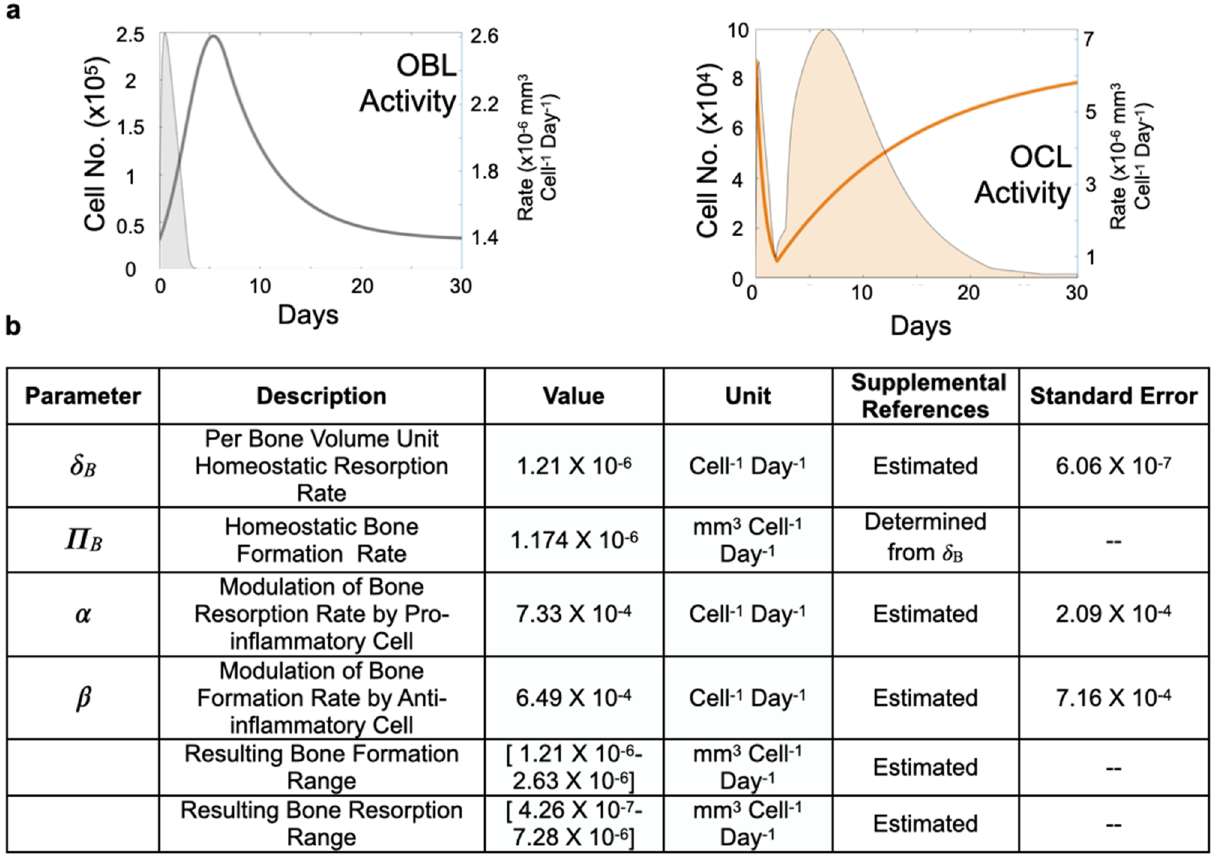
Figure 5. OCL and OBL activities and numbers do not correlate and vary distinctly across in bone injury repair. ( a ) OBL and OCL activity rate dynamics (filled curves plotted on the right y-axis) are plotted against their population dynamics (unfilled curves plotted on the left y-axis). Activity is temporally distinct from population dynamics, both combine to recapitulate bone dynamics. ( b ) Table detailing the known parameters used by model to estimate/infer unknown